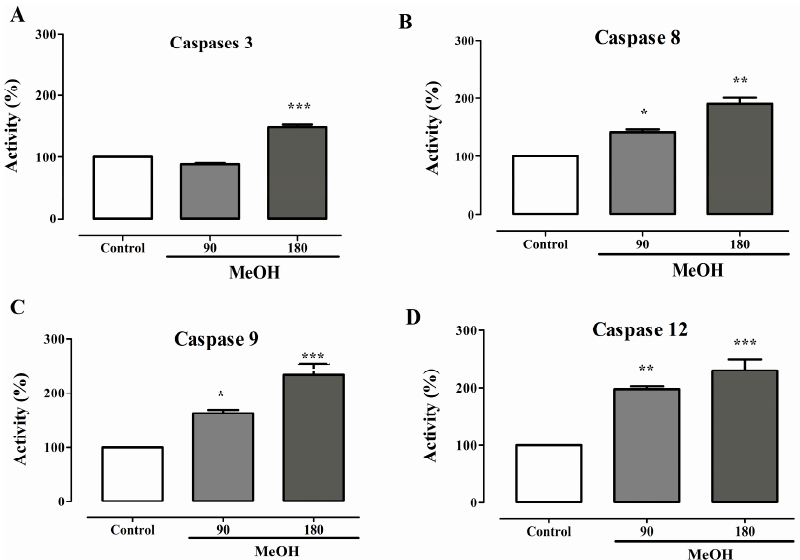
Figure 8. Effects of F. umbellata MeOH extract on caspases activities. Activation of caspase-3 ( A ), caspase-8 ( B ), caspase-9 ( C ) and caspase-12 ( D ) by F. umbellata MeOH extract. Cells were incubated